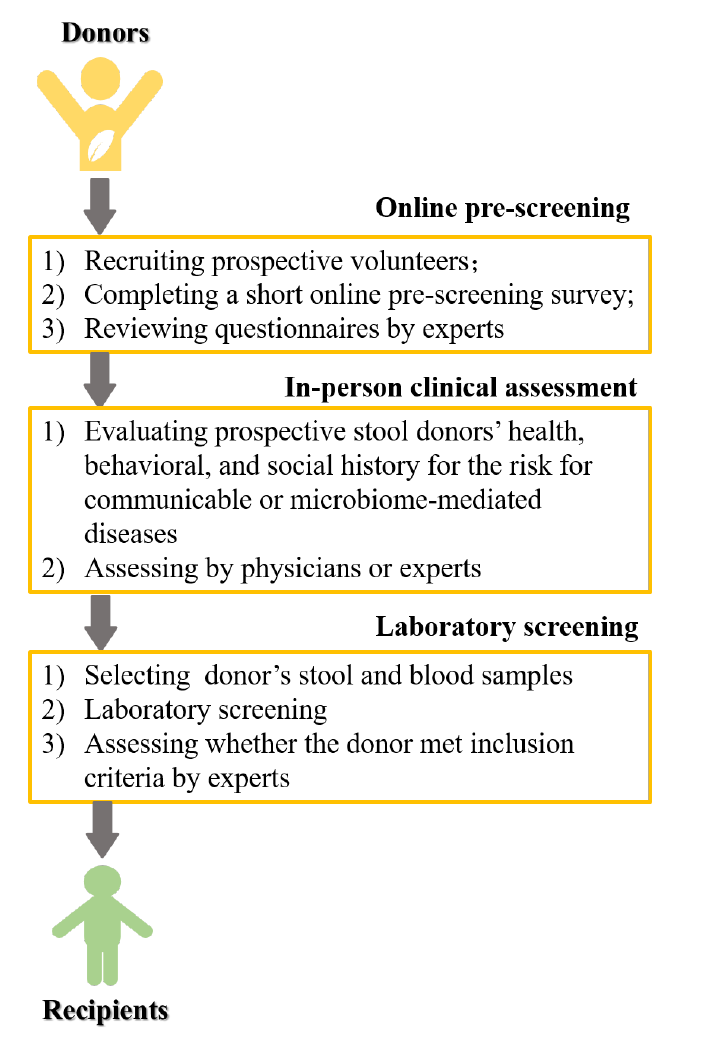
Figure 2. The process of FMT donor selection.